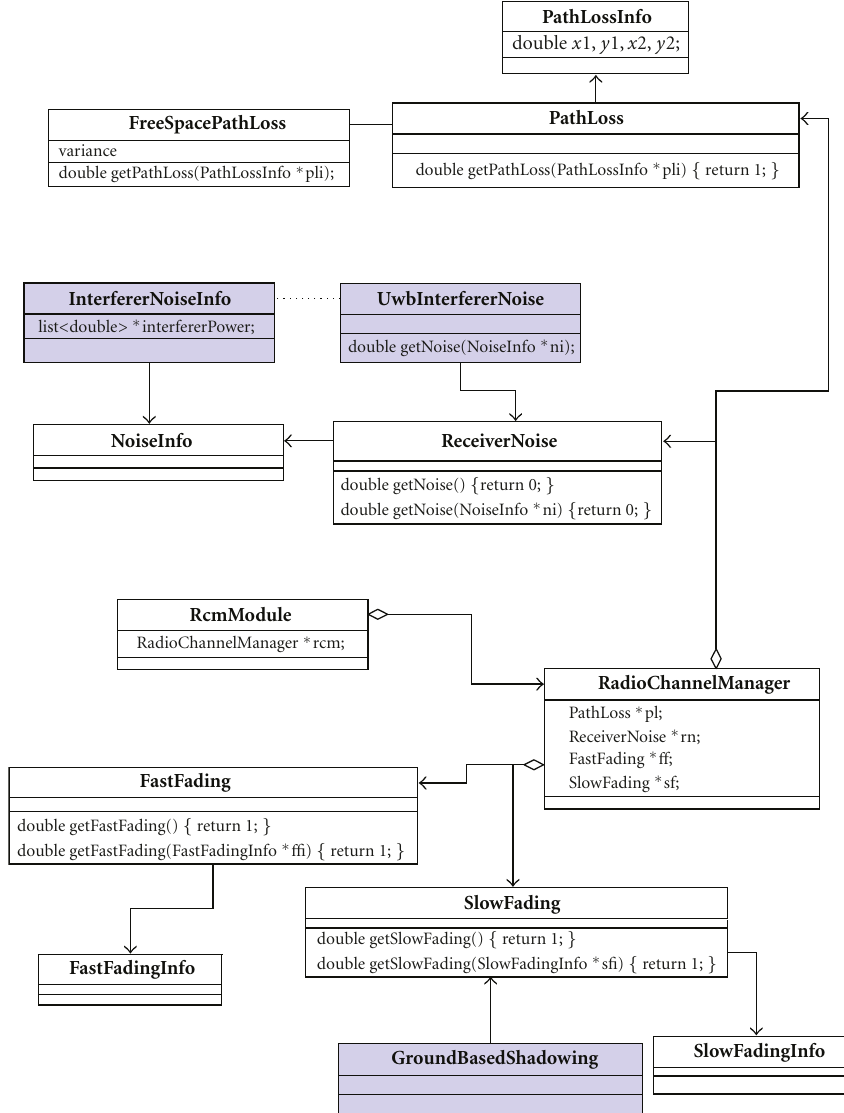
Figure 5: Radio channel manager class